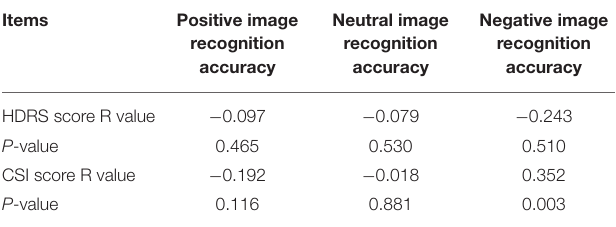
TABLE 4 | Correlated analysis between emotional images with HDRS and CSI scores ( n =